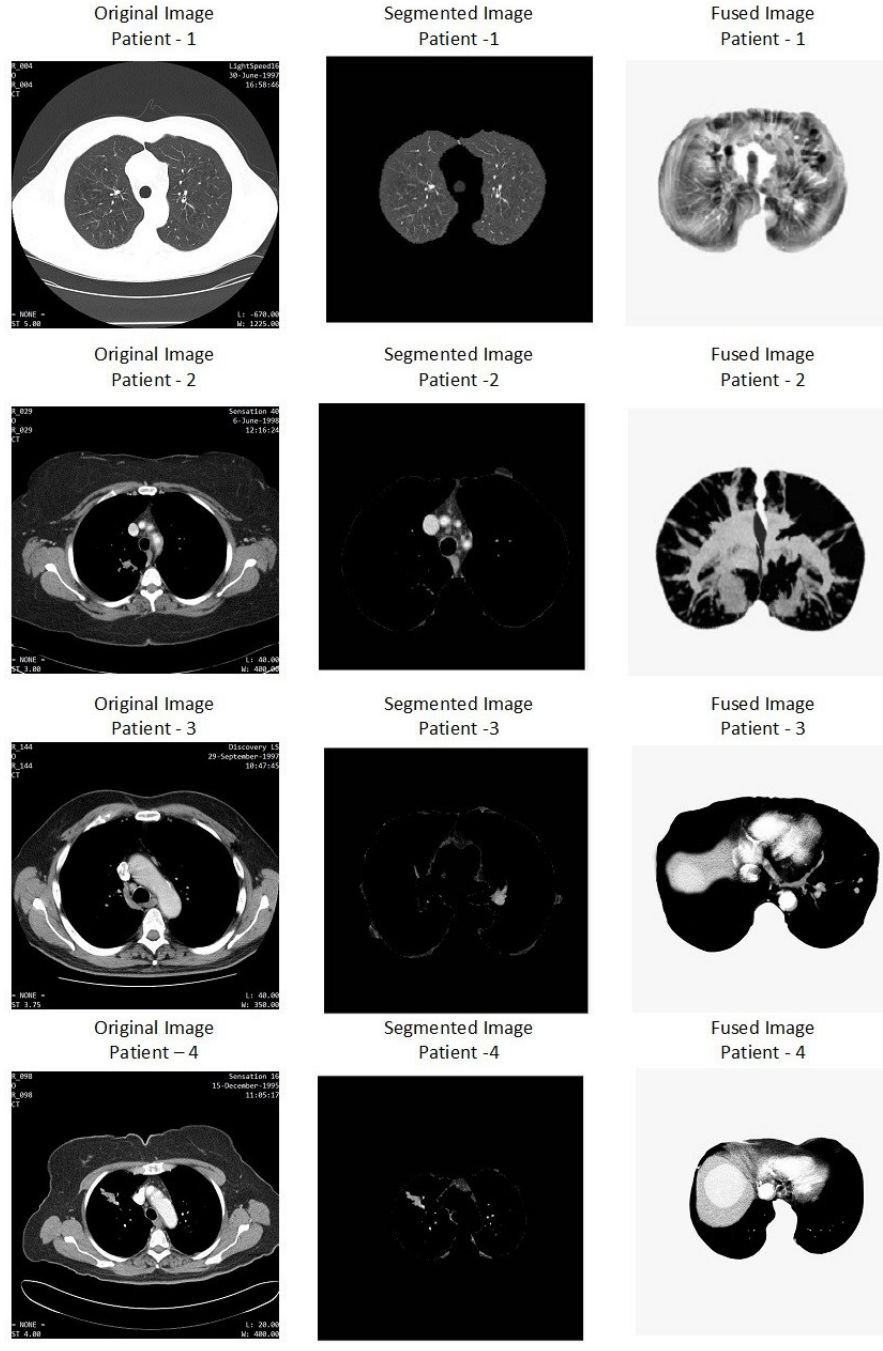
Figure 12. Final fused results of lung CT images of different